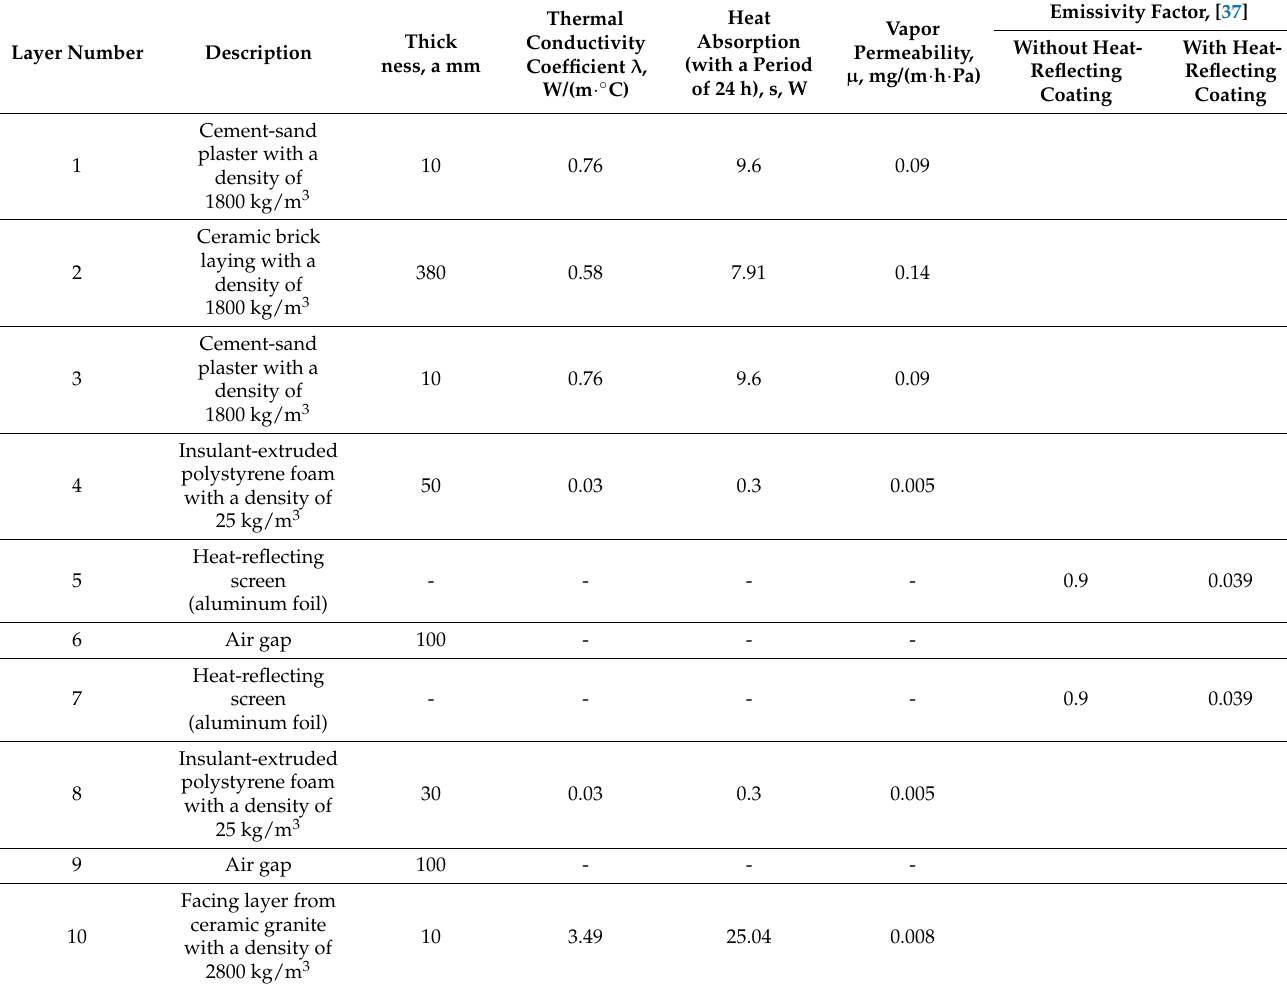
Table 2. Characteristics of the enclosing structure layers according to Figures 2–4